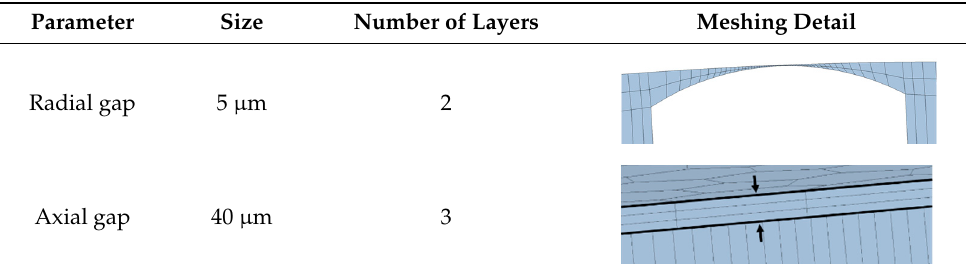
Table 1. Meshing details of the radial and axial gaps.